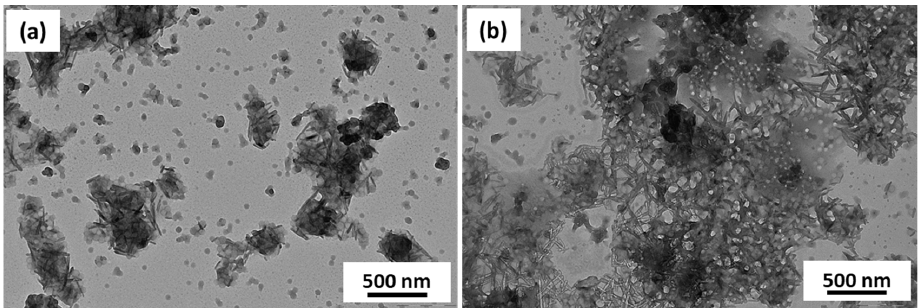
Figure 6. TEM images obtained for PDMA 58 –PBzMA 198 -PHCFDDMA x prepared at 10% w / w with ( a ) x = 19 ( b ) x = 50.